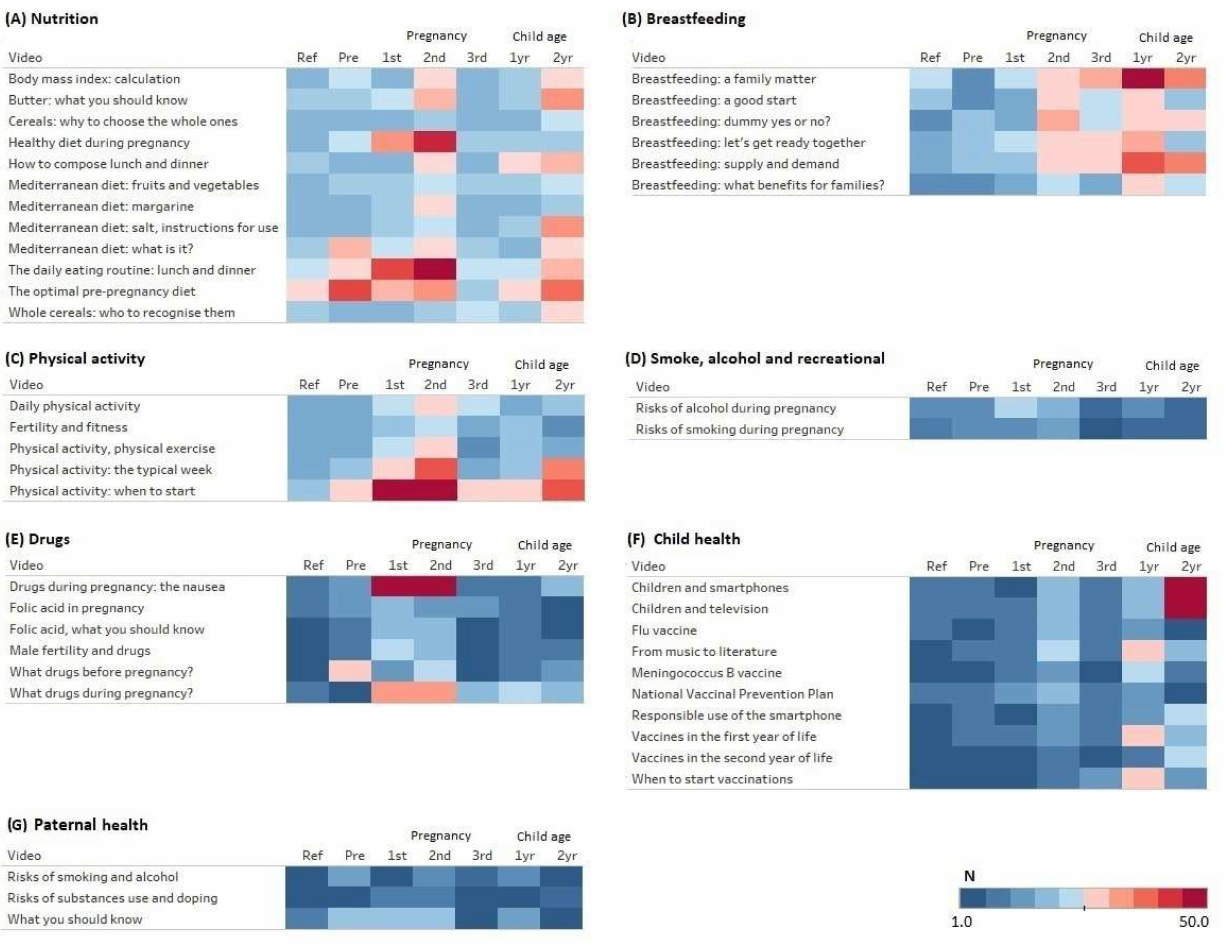
Figure 1. Absolute frequency of video views by topic and users’ category. Ref: not planning a pregnancy, not experiencing a pregnancy, and not having children in the first 2 years of life; Pre: planning for pregnancy; 1st: expectant parents first trimester; 2nd: expectant parents second trimester; 3rd: expectant parents third trimester; 1 year: parents of children <1 year; 2 year: parents of children